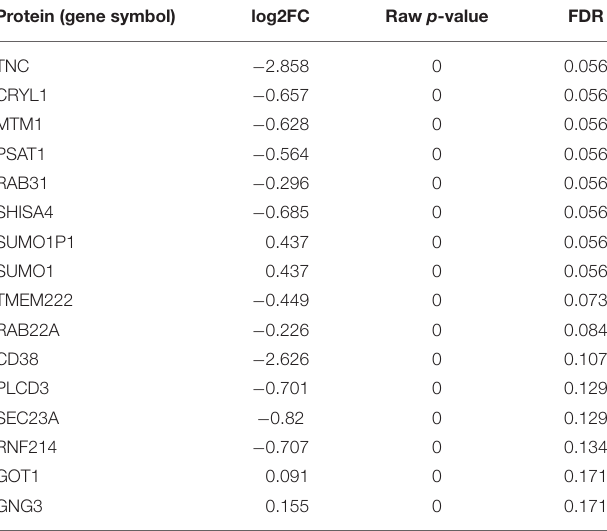
Frontiers in Molecular Biosciences |